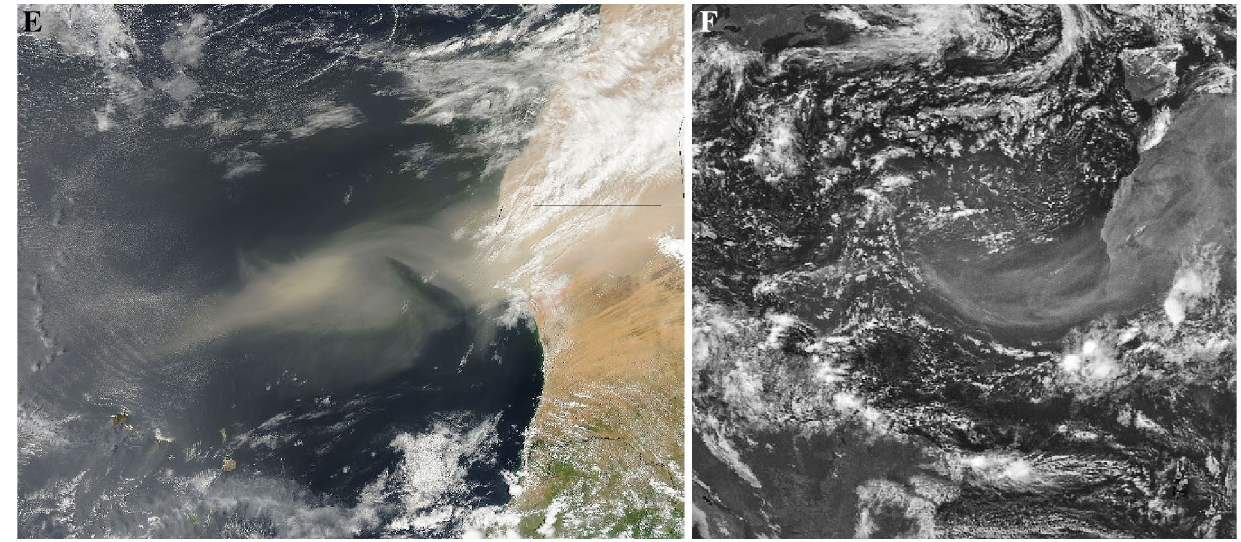
Fig. 3 True-color image of dust ( e ) and image enhancement ( f ) 2012 June